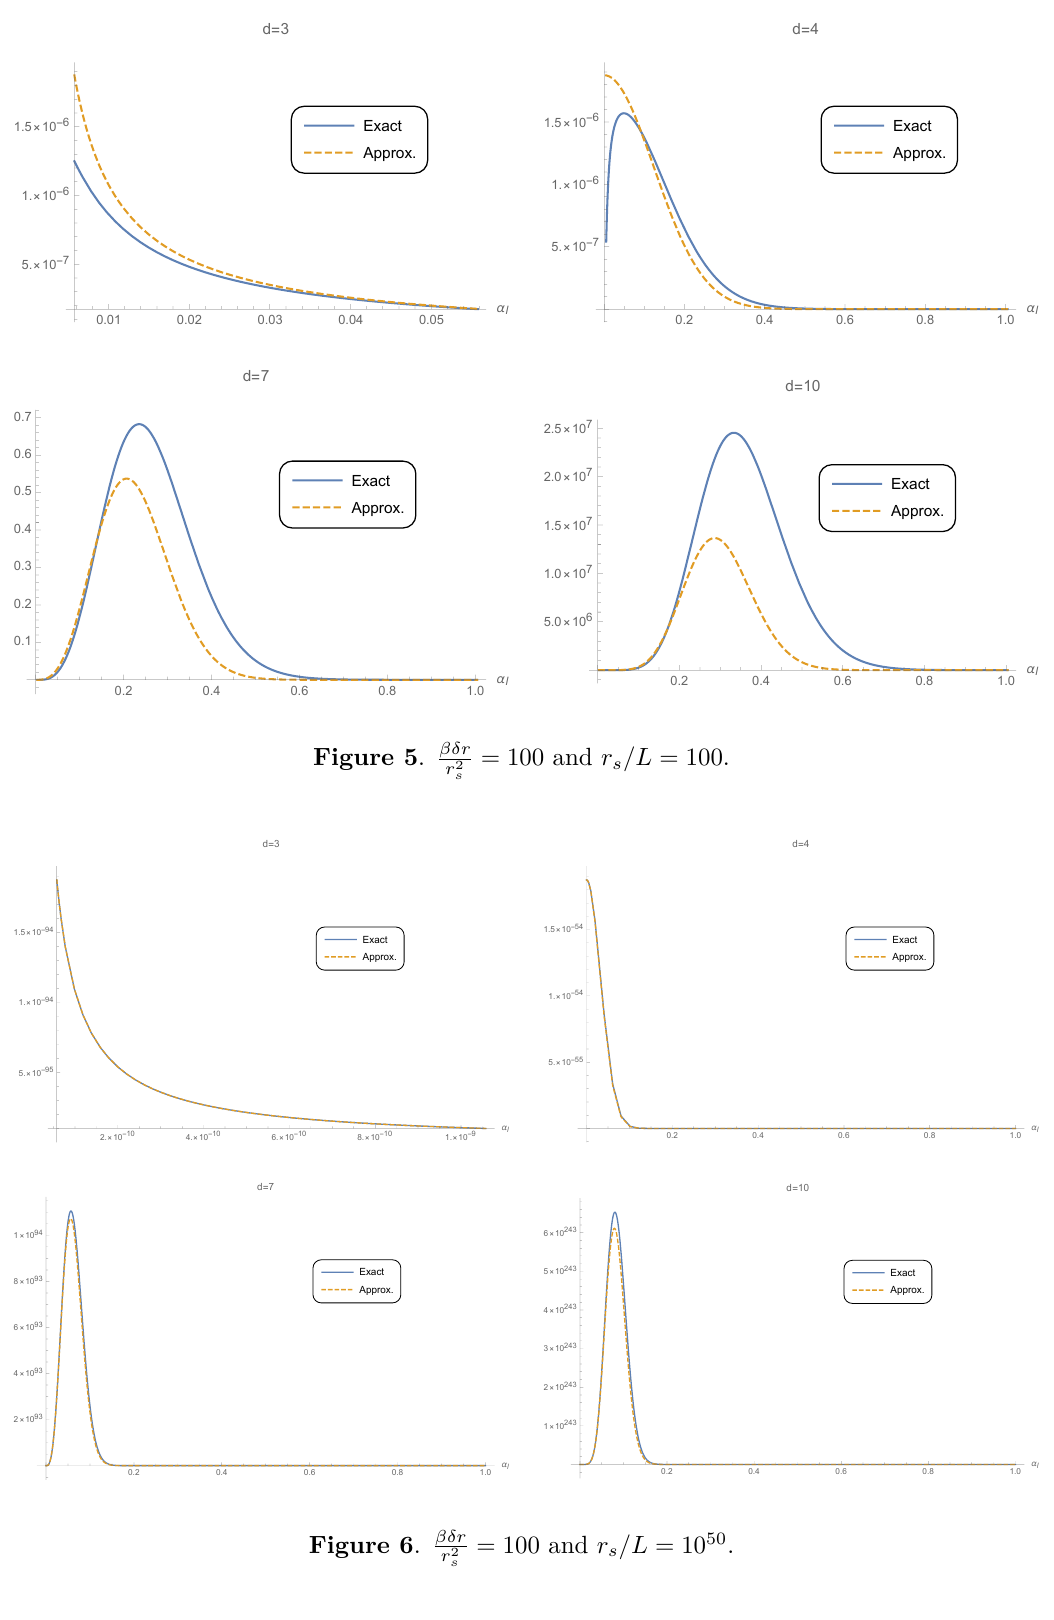
Figure 6 . βδr = 100 and r s /L = 10 50 r 2 s